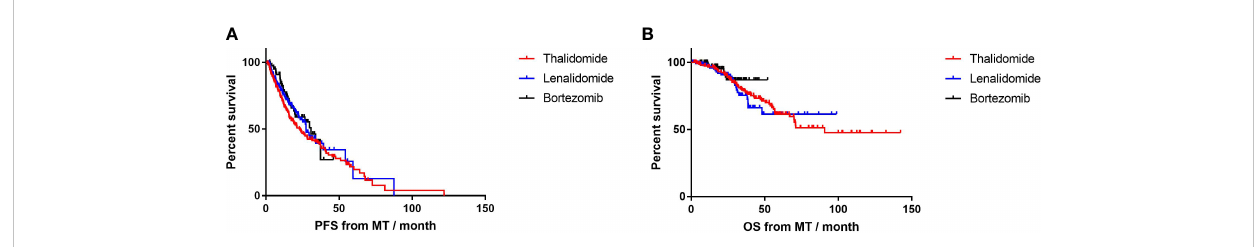
FIGURE 2 Progression-free survival (PFS) and overall survival (OS) in patients receiving lenalidomide, bortezomib, and thalidomide as maintenance. (A) The median PFS of lenalidomide, bortezomib, and thalidomide maintenance was 27.4, 30.8, and 23.2 months, respectively. (B) The median OS of lenalidomide, bortezomib, and thalidomide maintenance was not reached, not reached, and 90.7months, respectively.